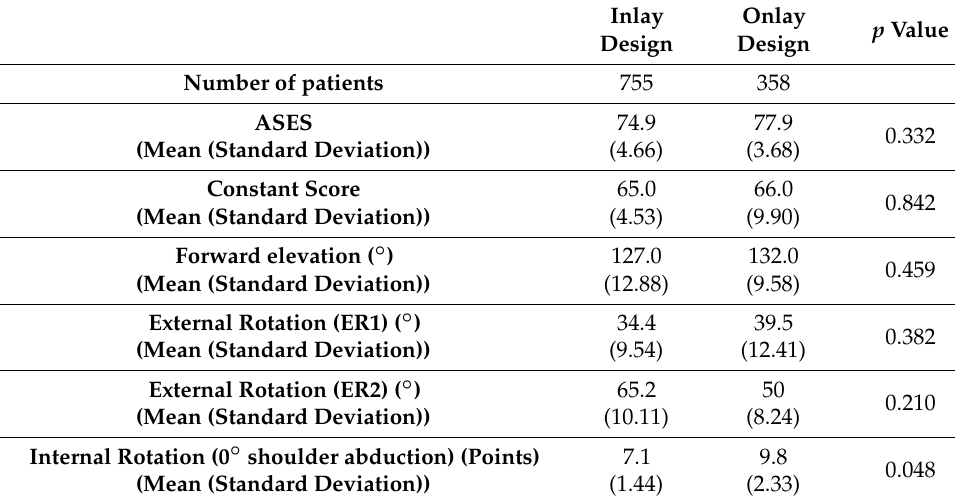
Table 6. Comparison of inlay and onlay humeral designs.